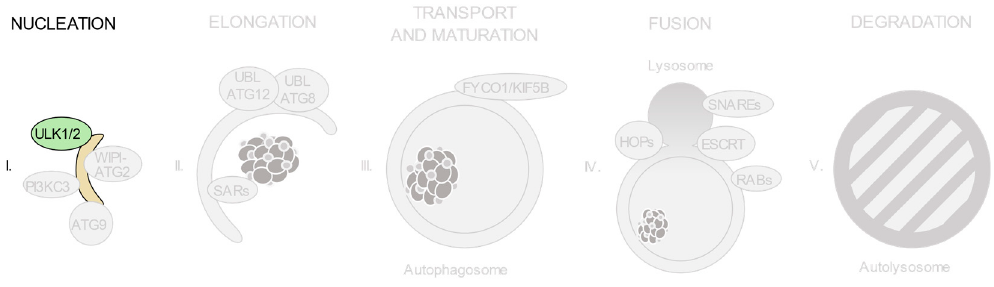
Figure 3. The ULK1/2 kinase complex participates in the nucleation of the pre-autophagosomal